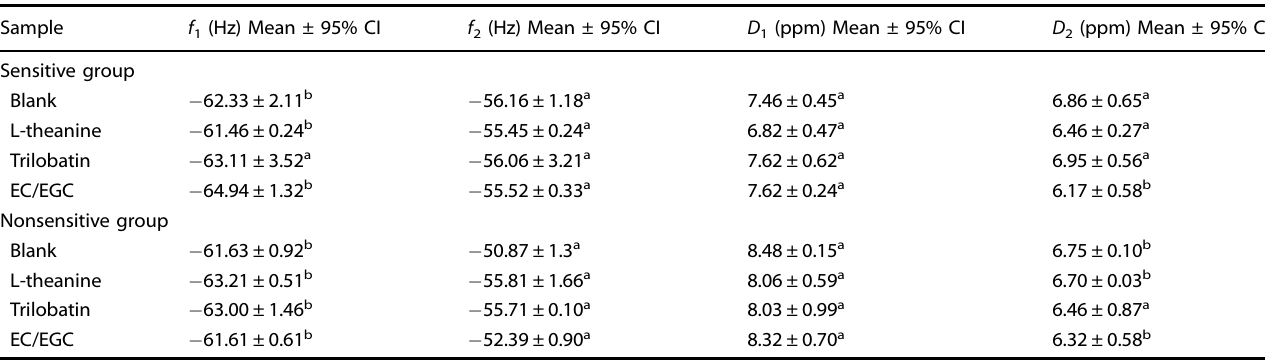
Fig. 5 Representative curves for the dissipation change over time for the 3rd overtone generated by the adsorption of saliva- sample mixture onto the gold sensor. a , b Sensitive group and non-sensitive group, respectively. Table 3. The frequency and dissipation (3 rd overtone) of saliva-sample fi lm from sensitive and nonsensitive